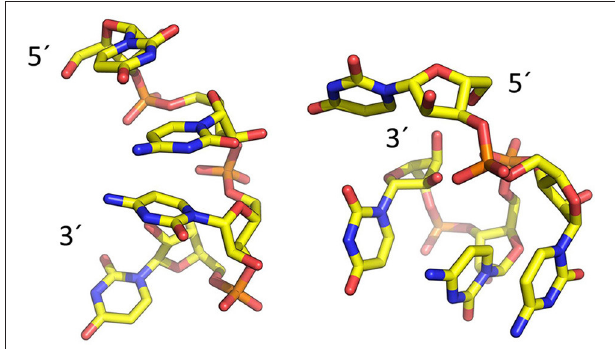
FIGURE 1 | Amyloid fibril models. The structural organization of the SNQNNF and GYMLGS sequences from which the fibril models have been built were taken from Sawaya et al. (2007) and Apostol et al. (2010). Residues with solvent exposed side chains are depicted in blue.